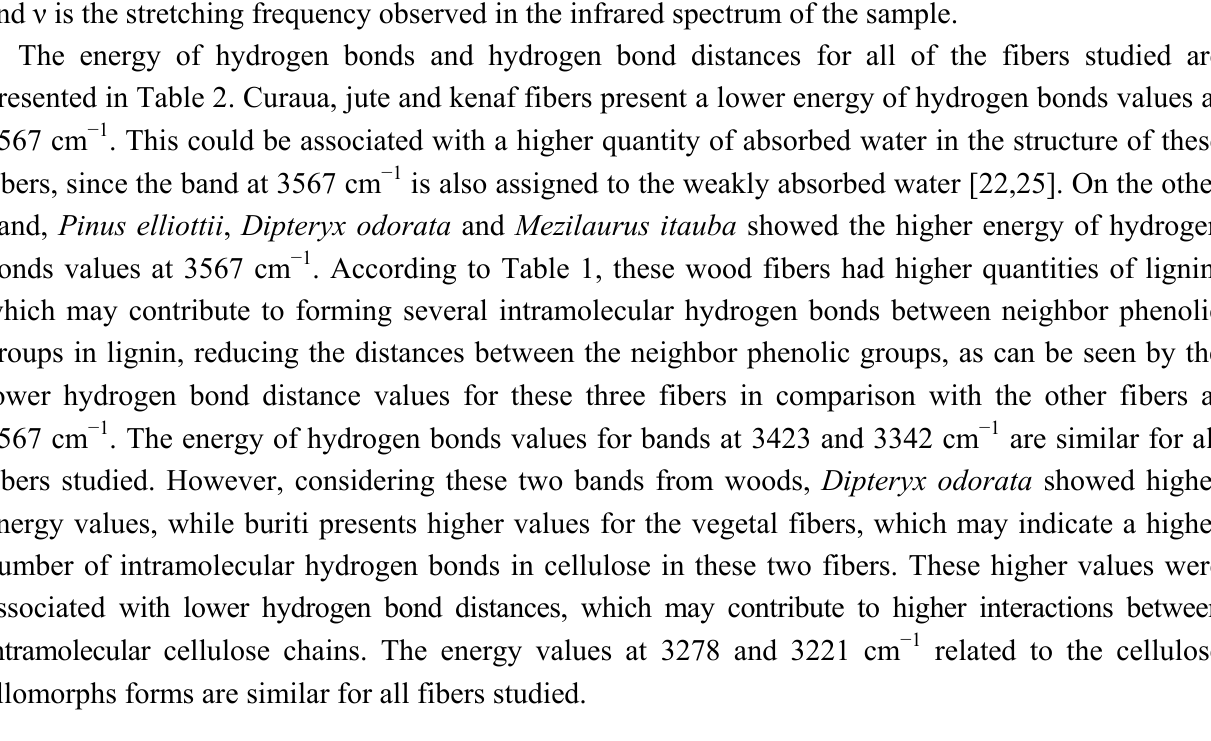
Table 2. Energy of the hydrogen bonds and hydrogen bond distance for the fibers studied. Fibers Eucalyptus grandis